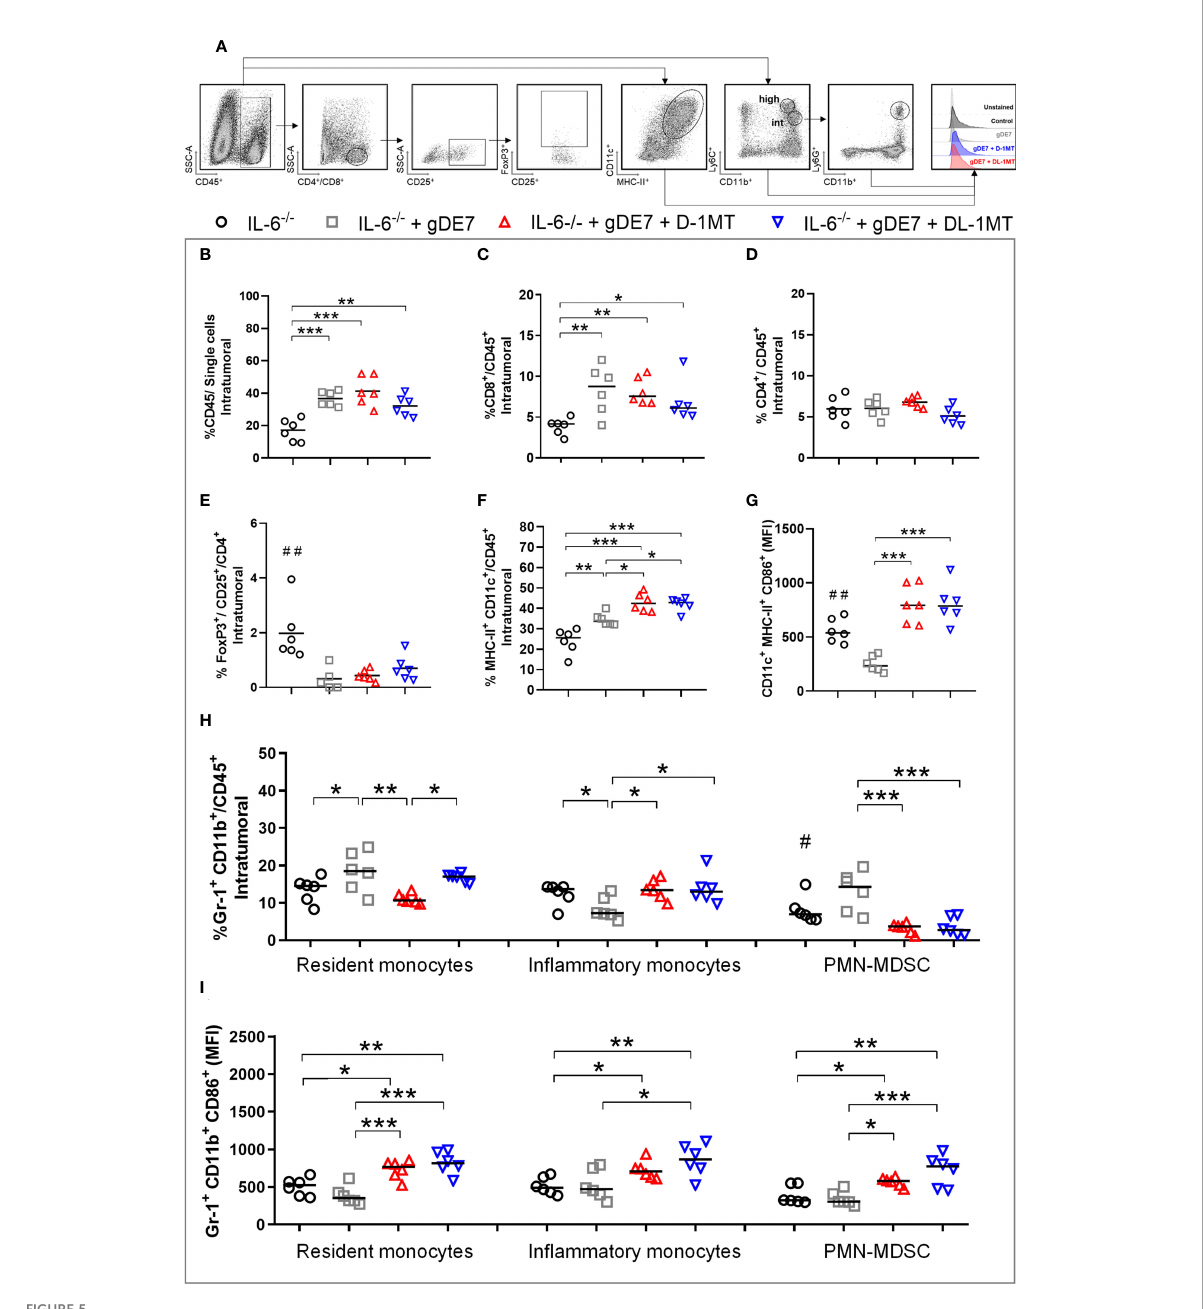
FIGURE 5 IDO inhibition increases activation of intratumoral DCs and decreases immune suppressive PMN-MDSC in tumor microenvironment of IL-6- / - mice immunized with gDE7. (A) Gating strategy for immune cell analyses of the tumor microenvironment, evaluated at day 21 after the tumor engraftment. Cells were gated by the expression of CD45 + and successively analyzed according to the expression of CD8 + (CD8 + T lymphocytes), CD4 + (CD4 + T lymphocytes) followed by CD25 + and FoxP3 + CD25 + (T regulatory cells); CD11c high MCH-II high (dendritic cells), CD11bint Ly6Cint Gr1 - (resident monocytes), CD11b int Ly6C high Ly6G - (in fl ammatory monocytes) or CD11b high Ly6C int Ly6G + (PMN-MDSC). Antigen-presenting cells were considered activated by the expression of the co-stimulatory molecule CD86, analyzed by the median of fl uorescence intensity (MFI) in the gated subsets cells. (B) Frequencies of CD45 + cells. (C) Frequencies of CD8 + cells. (D) Frequencies of CD4 + cells. (E) Frequency of FoxP3 + CD25 + CD4 + cells. (F) Frequencies of CD11c high MCH-II high cells. (G) CD86 MFI in CD11c high MCH-II high cells. (H) Frequencies of Gr1 + (Ly6C + /Ly6G - or Ly6C - /Ly6G + ) CD11b + cells. (I) CD86 MFI in Gr1 + CD11b + subsets cells. Data representative of two independently performed experiments (n=6). Statistical signi fi cance: (*) p<0.05, (**) p<0.01, (***) p<0.001 by ANOVA. (#) p<0.05 and (##) p<0.01 represent the statistical signi fi cance of control group versus other